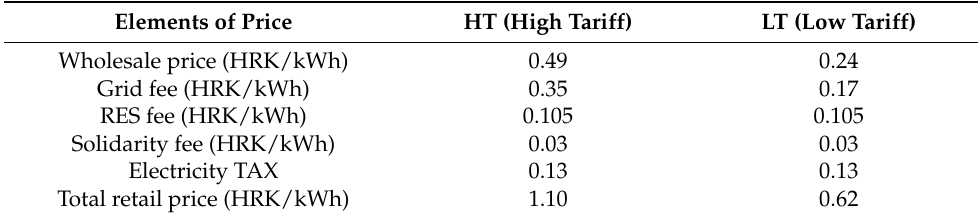
Table 3. Input values for the calculation of electricity